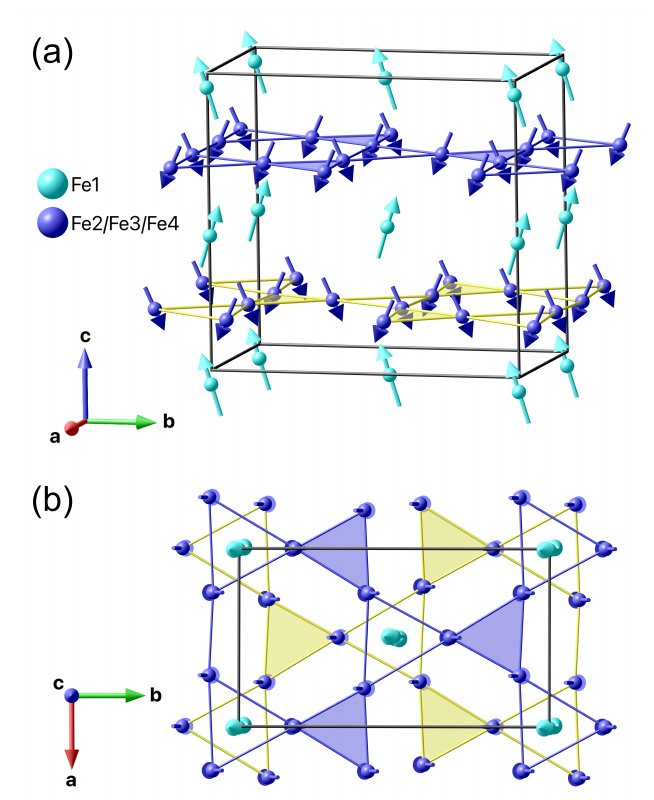
Figure 4: (a) Perspective view of the magnetic structure in CaBaFe O at 220 K. Only 4 7 the magnetic ions on the triangular (light blue) and hexagonal sites (dark blue) are shown. Bonds between Fe ions in the kagome planes are drawn as a guide to the eye. The kagome plane at z ∼ 0.2 is emphasized in yellow in order to be distinguished from the one at z ∼ 0.7. T triangles are open, while T triangles are filled. (b) 1 2 View along the c axis emphasizing the b component of the magnetic moments. All Fe triangles in the kagome plane reveal 2 spins pointing along the positive (negative) b axis, while 1 spin is pointing along the negative (positive) b